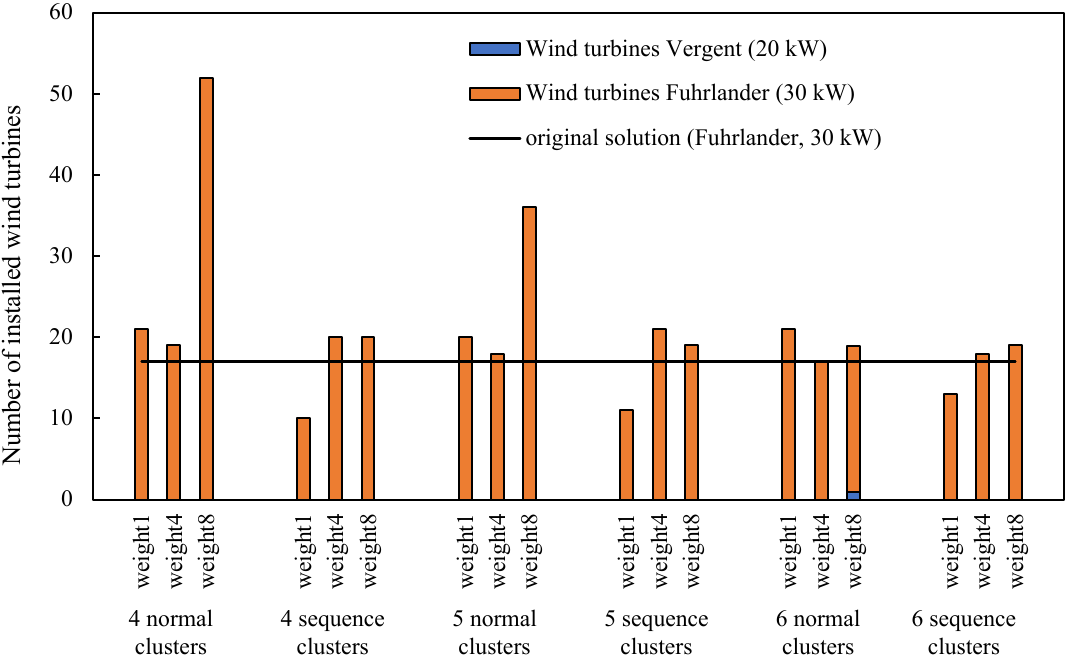
Figure 11. Number of fossil-powered units in the energy hub under the GHG emissions constraint.